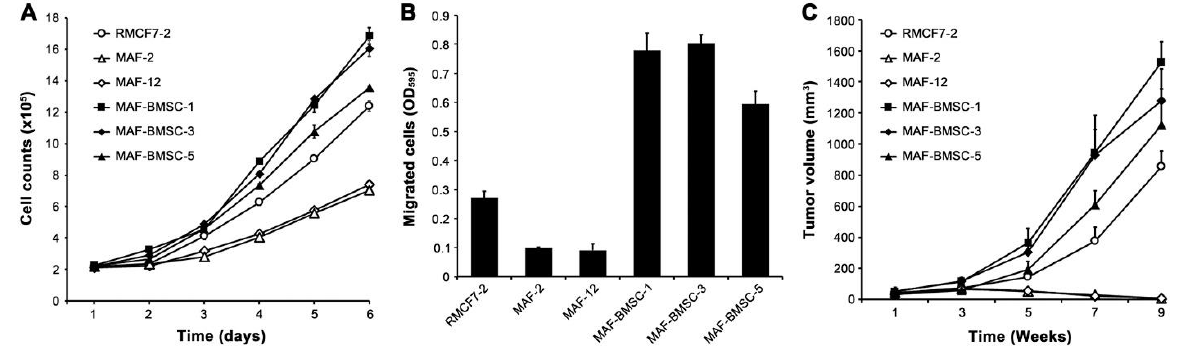
Figure 7. Co-culture with bystander cells induced behavioral heterogeneity. Selected MAF-BMCS- clones (-1, -3, and -5) were compared with the parental MAF clones (-2 and -12) and the grand- parental RMCF7-2 clone for behavioral changes. ( A ) Growth rates were compared by counting the growth of an equal number of cells daily. Data are shown as the cell count average of triplicate wells ± STDEV. ( B ) Migration capabilities were compared by seeding an equal number of cells in a 48-h transwell assay. Data are shown as the crystal violet stain average of triplicate wells ± STDEV. ( C ) Increased xenograft tumor formation capability in MAF-BMSC-clones was revealed through ortho- topic mammary fat pad tumor formation ( n = 6). Null of tumor formation by MAF-2 and MAF-12 cells was confirmed with additional animal studies. In all the assays, data are shown as tumor vol- ume average ± STDEV.